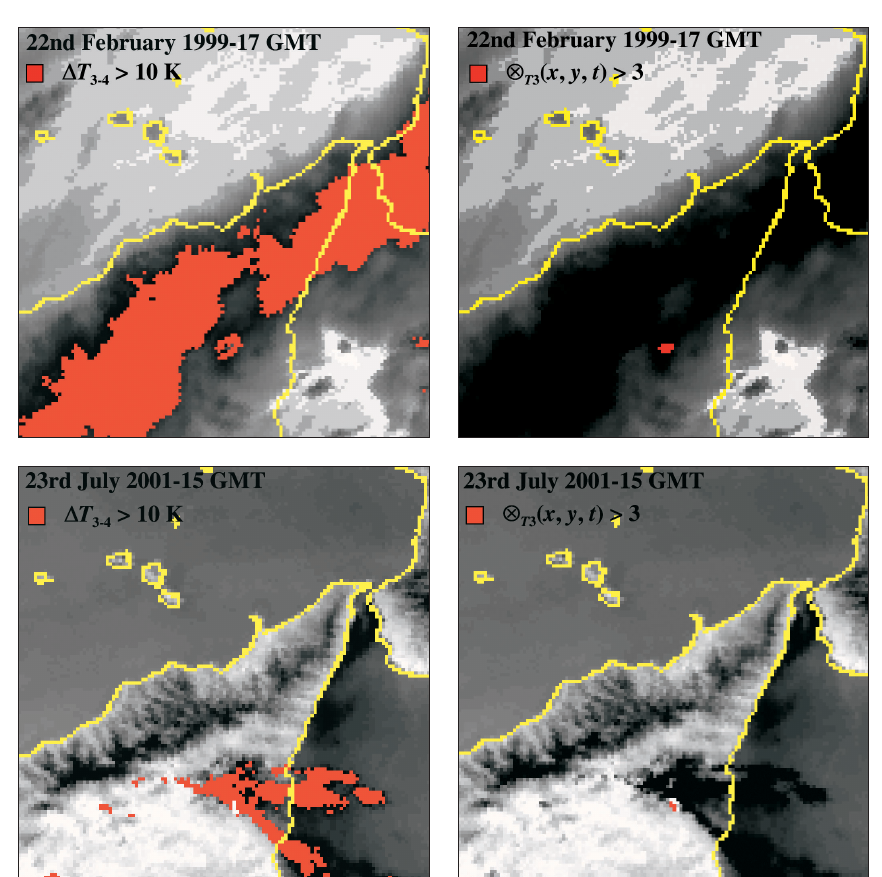
Fig. 3. The NOAA-AVHRR images above show the comparison between ( left ) the fixed threshold method of Harris et al. (1995) and the RAT technique ( right ) on February 22nd 1999, 17:00 GMT ( top ) and July 23rd 2001, 15:00 GMT ( bottom ) during Mount Etna eruptive activity: pixels identified as lava flows (see text) are depicted in red. In background AVHRR channel 4 Brightness Temperatures are depicted in grey tones (light tones corre- spond to lower BT values). Note how on 22nd February 1999 ( top-left ) the fixed threshold method generates sev- eral false alarms because of sensitivity of clouds to the dual-band test used. This problem does not affect ( top- right ) the RAT technique (based on a single-band) that detects hot-spots only on Mount Etna according to lava flows produced by the fracture opened on the flanks of volcano starting from 4th February 1999. In the case of 23rd July 2001 ( bottom-left ), the volcanic plume as well as high reflective soils are mistaken for lava flows by the fixed threshold approach. RAT technique ( bottom-right ) recognizes only hot-spots associated with the lava flows effectively produced from a series of new vents opened starting from 17th